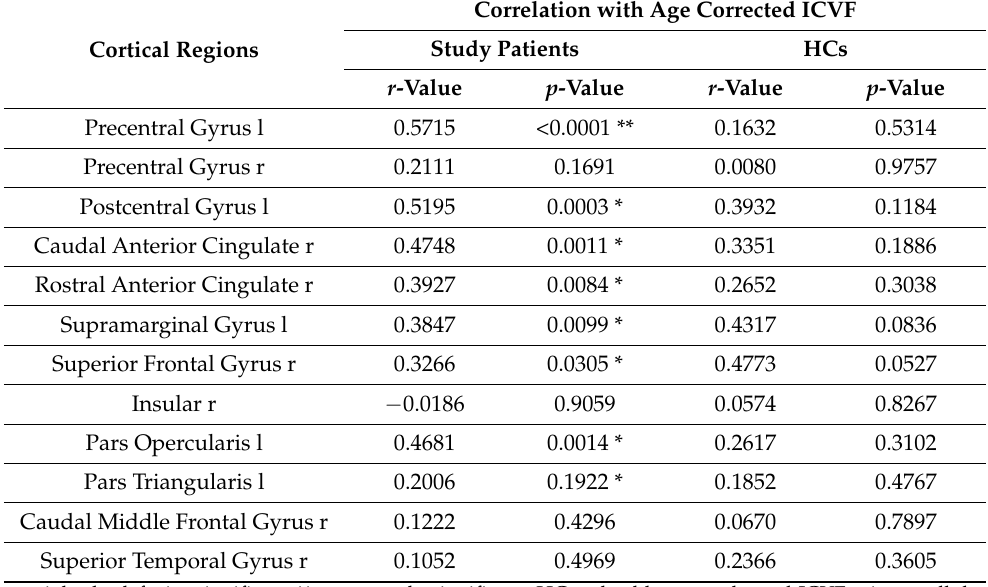
Table 3. Thinning Cortical Regions Showing Correlation between ICVF Values and Cortical Thickness in both Study Patients and